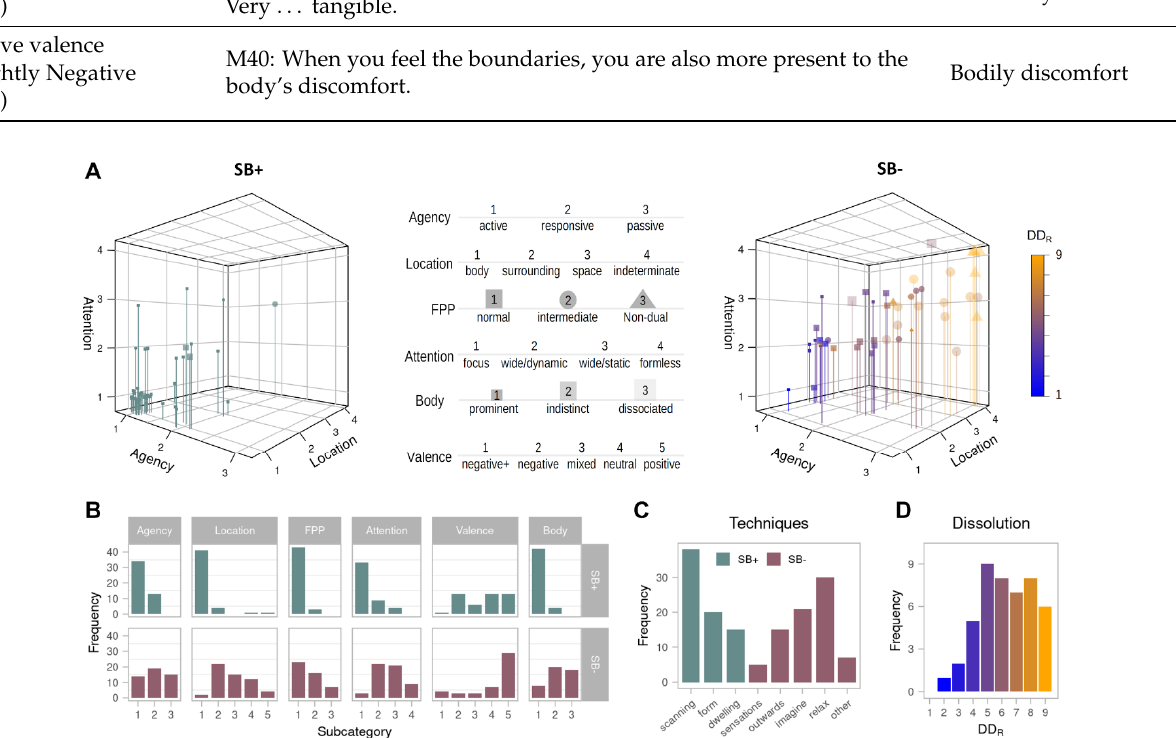
Figure 1. Descriptive figures of phenomenological results. Panel ( A ): Representation of the phenomenological space spanned by the Agency, Location, and Attention dimensions in the SB+ (left) and SB − (right) condition. Each data point represents one participant. Additionally, first-person perspective (FPP) is indicated by the symbol, the body sensations category by the saturation and size of markers and the rated degree of dissolution by the colour scale. Random noise was added to the individual values to make overlapping points from different participants visible. For reference, the panel shows a short version of the labels of the subcategories, for a more detailed description of the subcategories please refer to Table 1. Panel ( B ): Frequencies of occurrence of the individual subcategories. Panel ( C ): Frequency of employed tech- niques. Panel ( D ): Distribution of the rated degree of dissolution (DD R ). Note that multiple assignments of subcategories were counted in panel ( D ), whereas a single value was obtained for the dimensional presentation in panels ( A ) and ( C ) (see methods Section 2.7 and results Section 3.3 for more details).